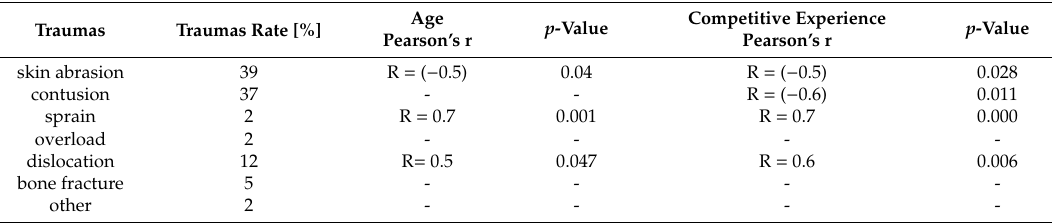
Table 3. Traumas vs. age and competitive